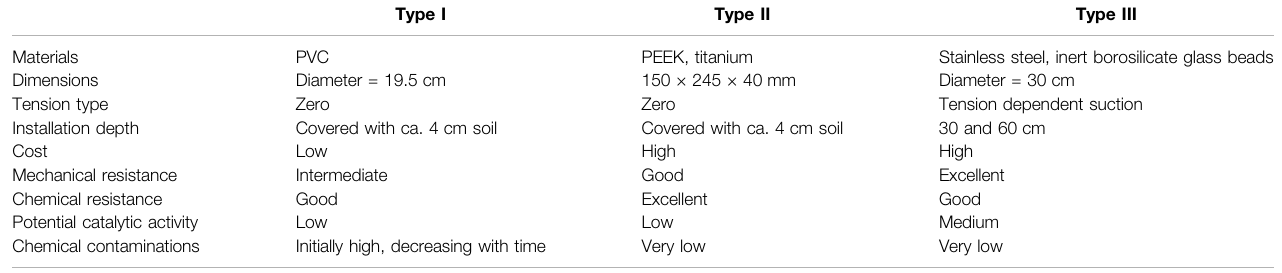
TABLE 1 | Relevant features of the employed lysimeters.